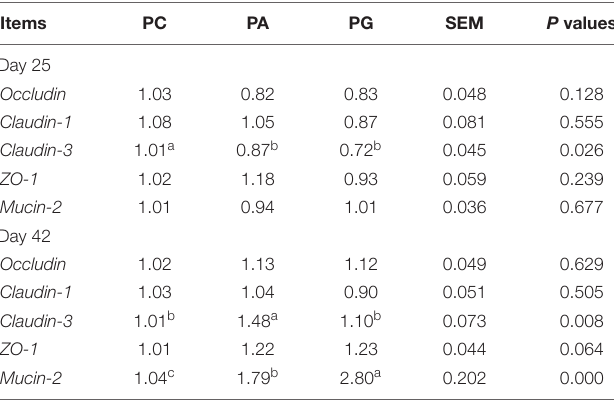
TABLE 5 | Effects of B. licheniformis and enramycin the amounts of bacteria (lg CFU/g 1 ) in cecal digesta of broilers challenged with SNE. Items